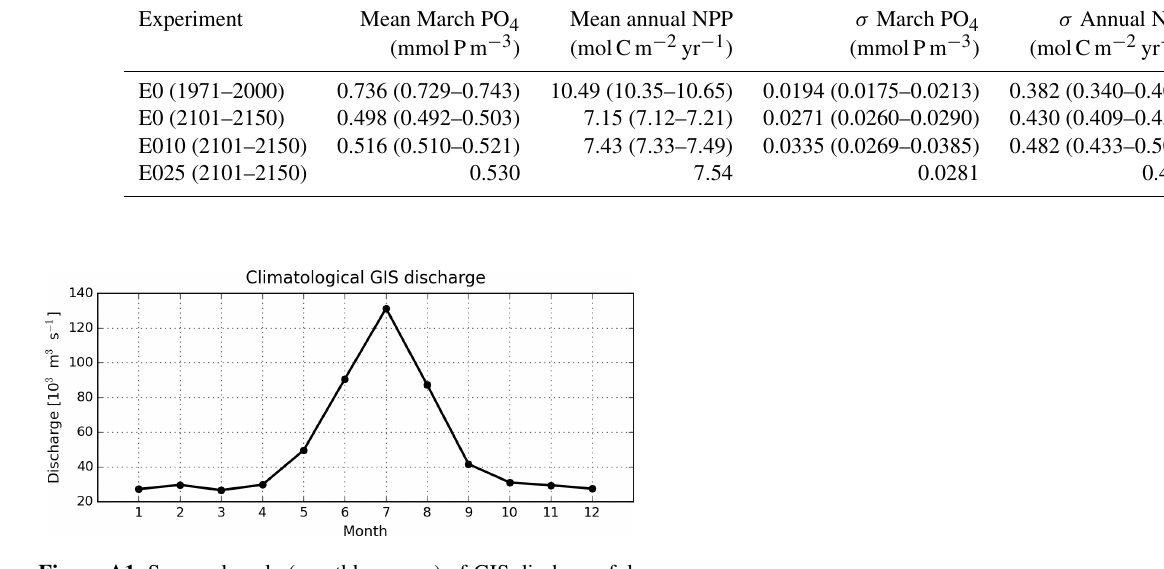
Figure A1. Seasonal cycle (monthly means) of GIS discharge fol- lowing the observational climatology by Martin et al. (2019). The spatial distribution of the annual mean is shown in Fig.